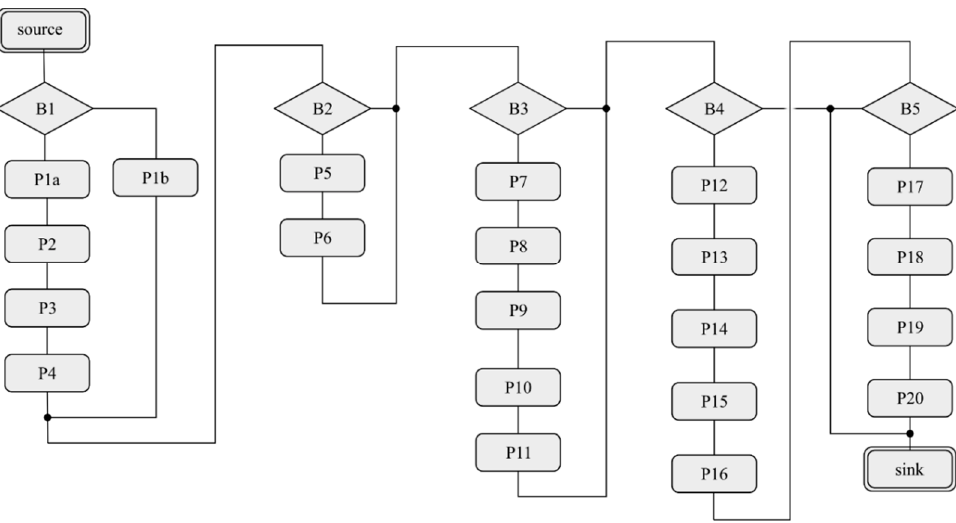
Figure 3. Identified layout of the production process (P: process step, B: branch).